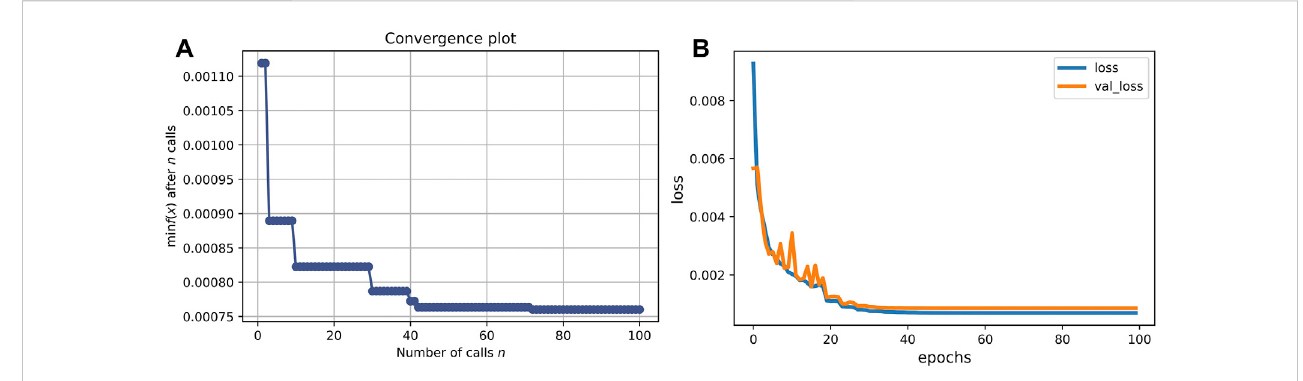
FIGURE 7 Iterative convergence of the objective function and loss